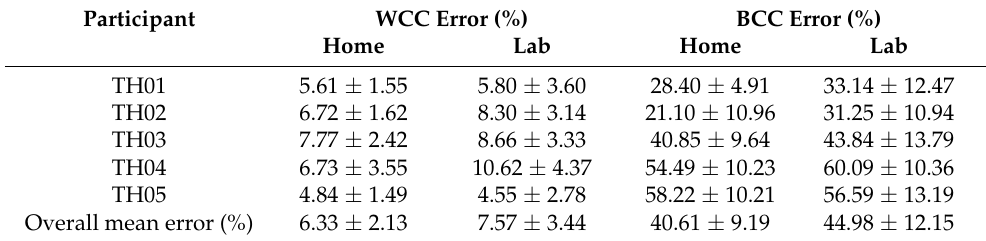
Table 3. Average classification error across calibrations.